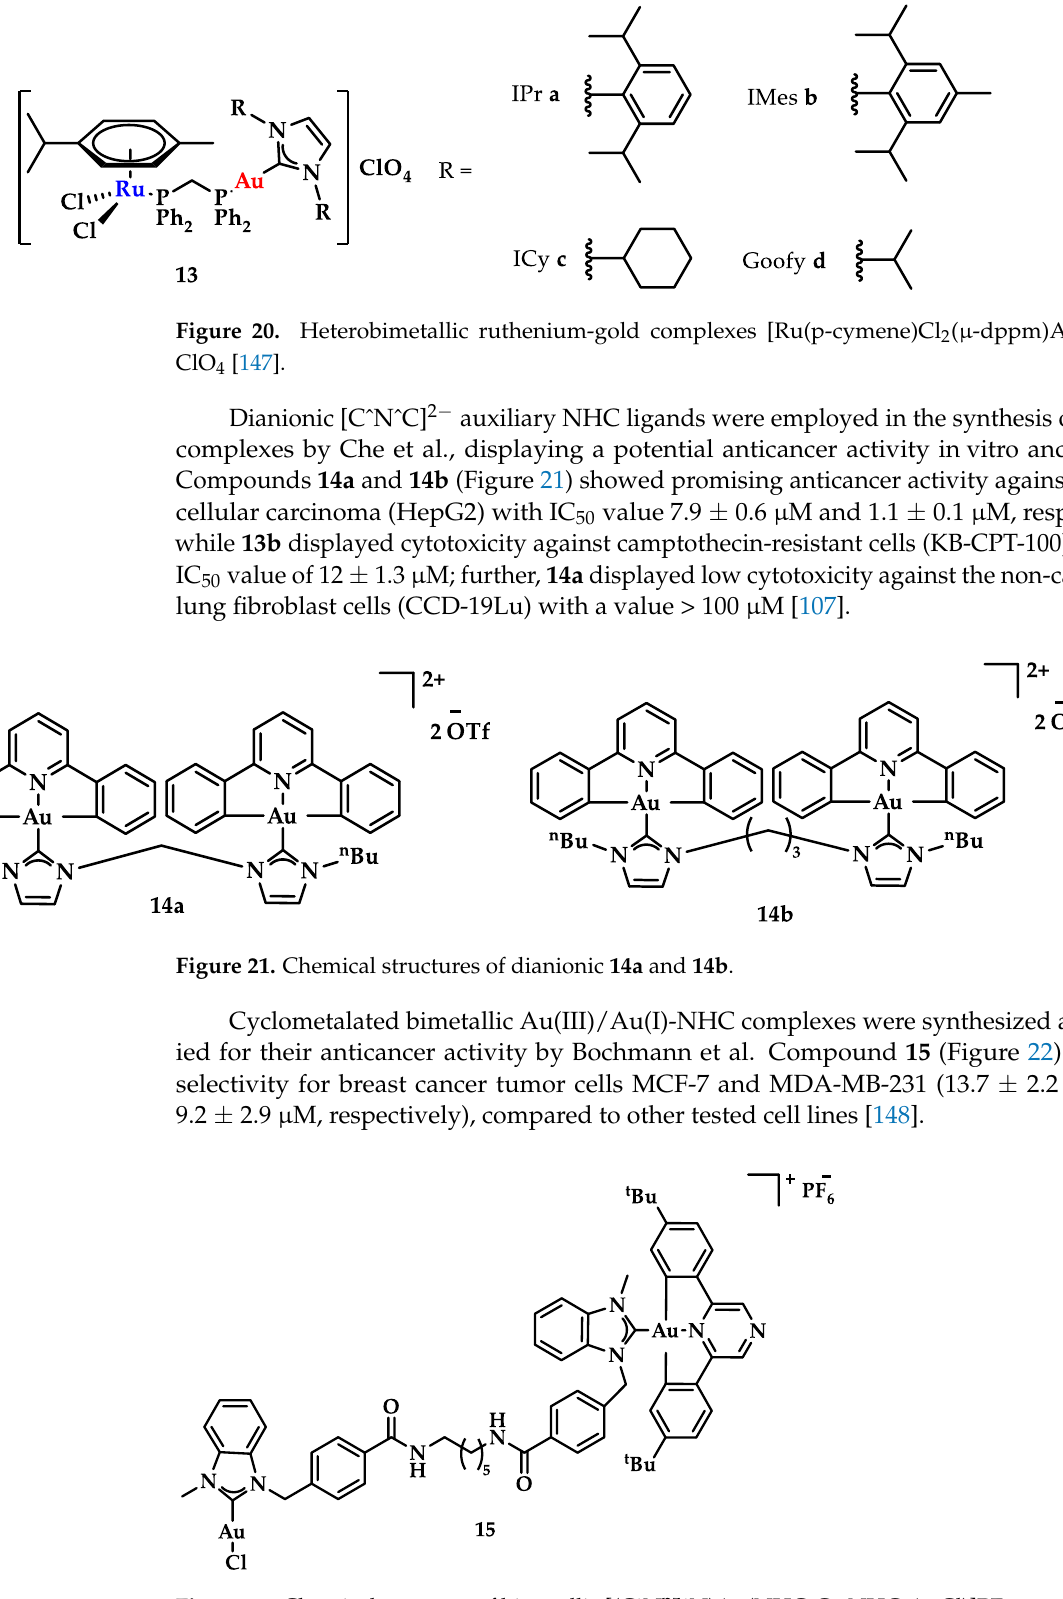
Figure 22. Chemical structure of bimetallic [(C^N pz ^N)Au(NHC-C 6 -NHC-AuCl)]PF 6 complex. Contel and coworkers synthesized a series of titanocene-gold-NHC complexes [([( η 5 - C 5 H 5 ) 2 TiMe(μ -mba)Au(NHC)] (NHC = SIPr ( 16a ), IPr ( 16b ), IMes ( 16c ), ICy ( 16d )) as po- tential antitumor agents (Figure 23). They were tested against renal, prostate, colon, and breast cancer lines and the non-tumorigenic embryonic kidney cell lines, while titanocene was used as a control. The comparison between the bimetallic complexes and their mon- omeric analogues indicated that, apart from the breast cancer lines, the bimetallic com- pounds displayed a higher cytotoxicity than their monomeric analogues. Their values are summarized in Table 1 [149].